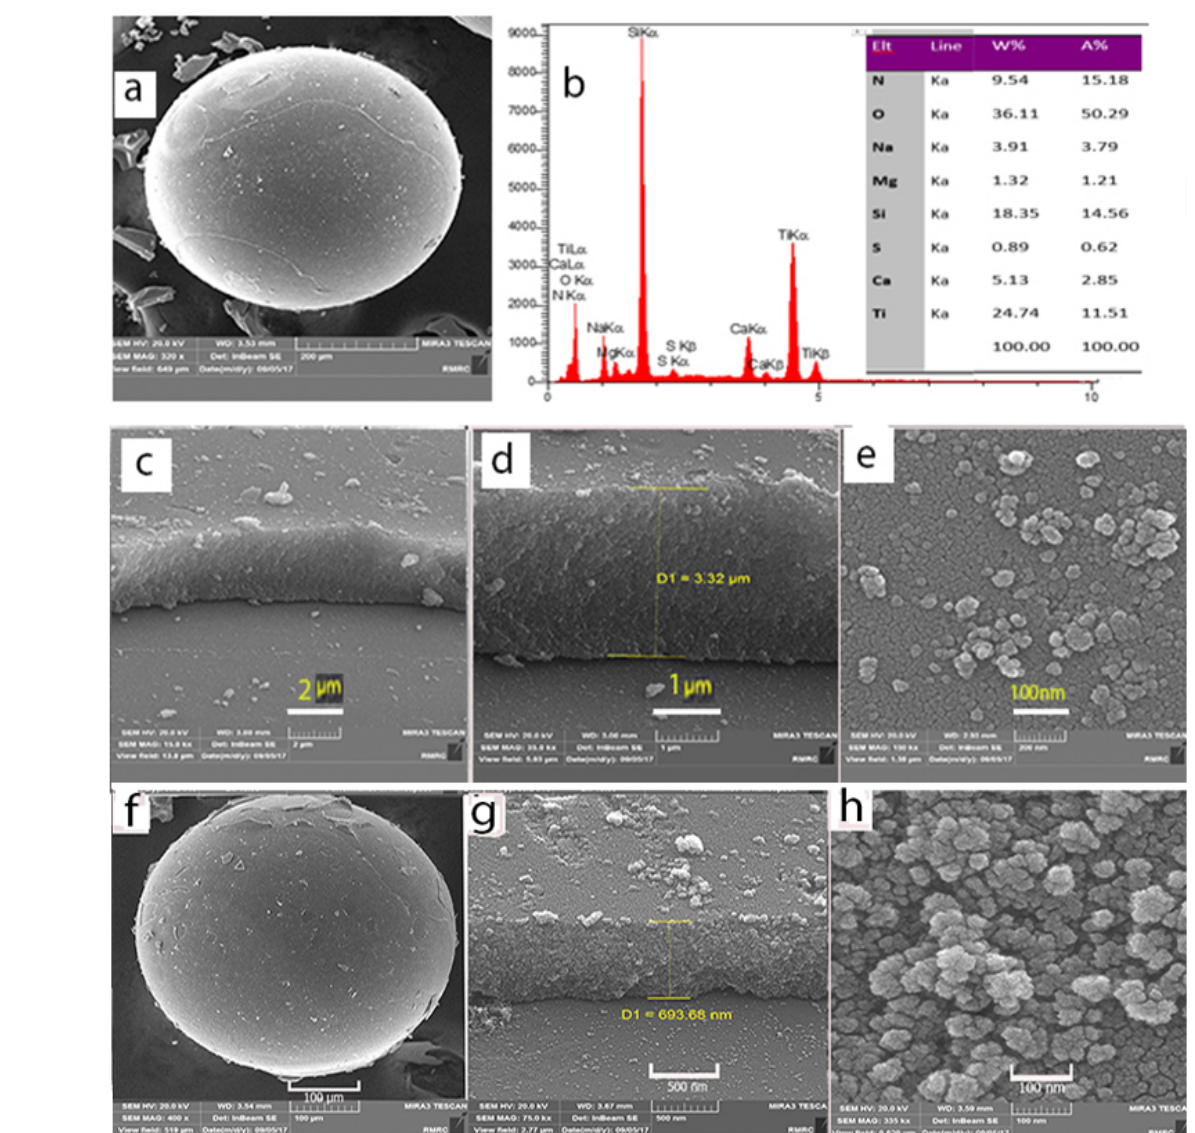
Figure 3. Energy-Dispersive X-ray (EDX) spectrum and Scanning Electron Microscope (SEM) images associated with N,S-TiO coated on Silica Sulfuric Acid (SSA) and N,S-TiO coated on pure glass Microspheres (MS), respectively 2 a) SEM image of N,S-TiO coated on SSA; b) EDX analysis of N, S-TiO coated on SSA; c) SEM image of a uniform thin film of N,S-TiO 2 2 coated on SSA; d) The thickness of N,S-TiO /SSA thin film (3.32 µm); e) Nanometer-sized N, S-TiO particles on SSA image with 2 2